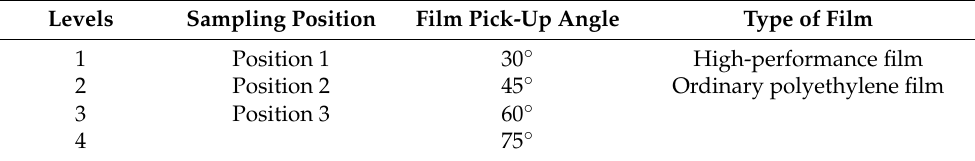
Table 1. Test factor